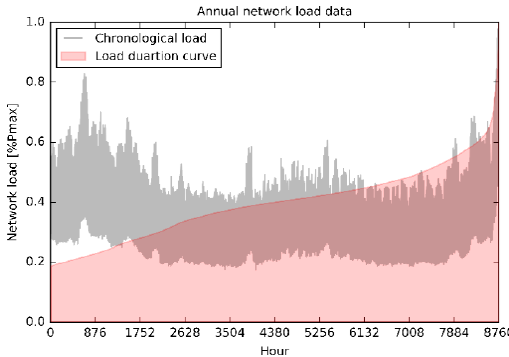
Figure 8. Network voltage profile for initial and optimal network topology.